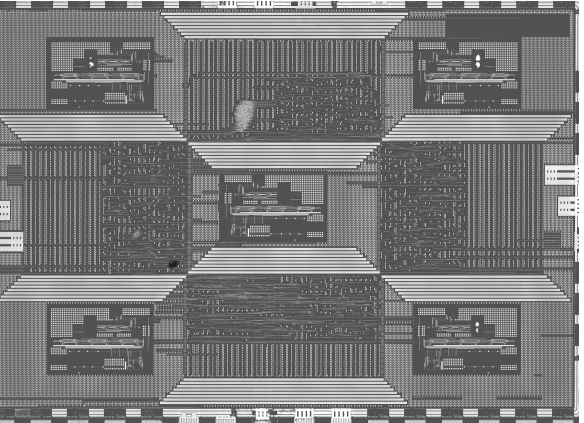
Figure 1. The full view of the chip’s image scanned by electron microscope.